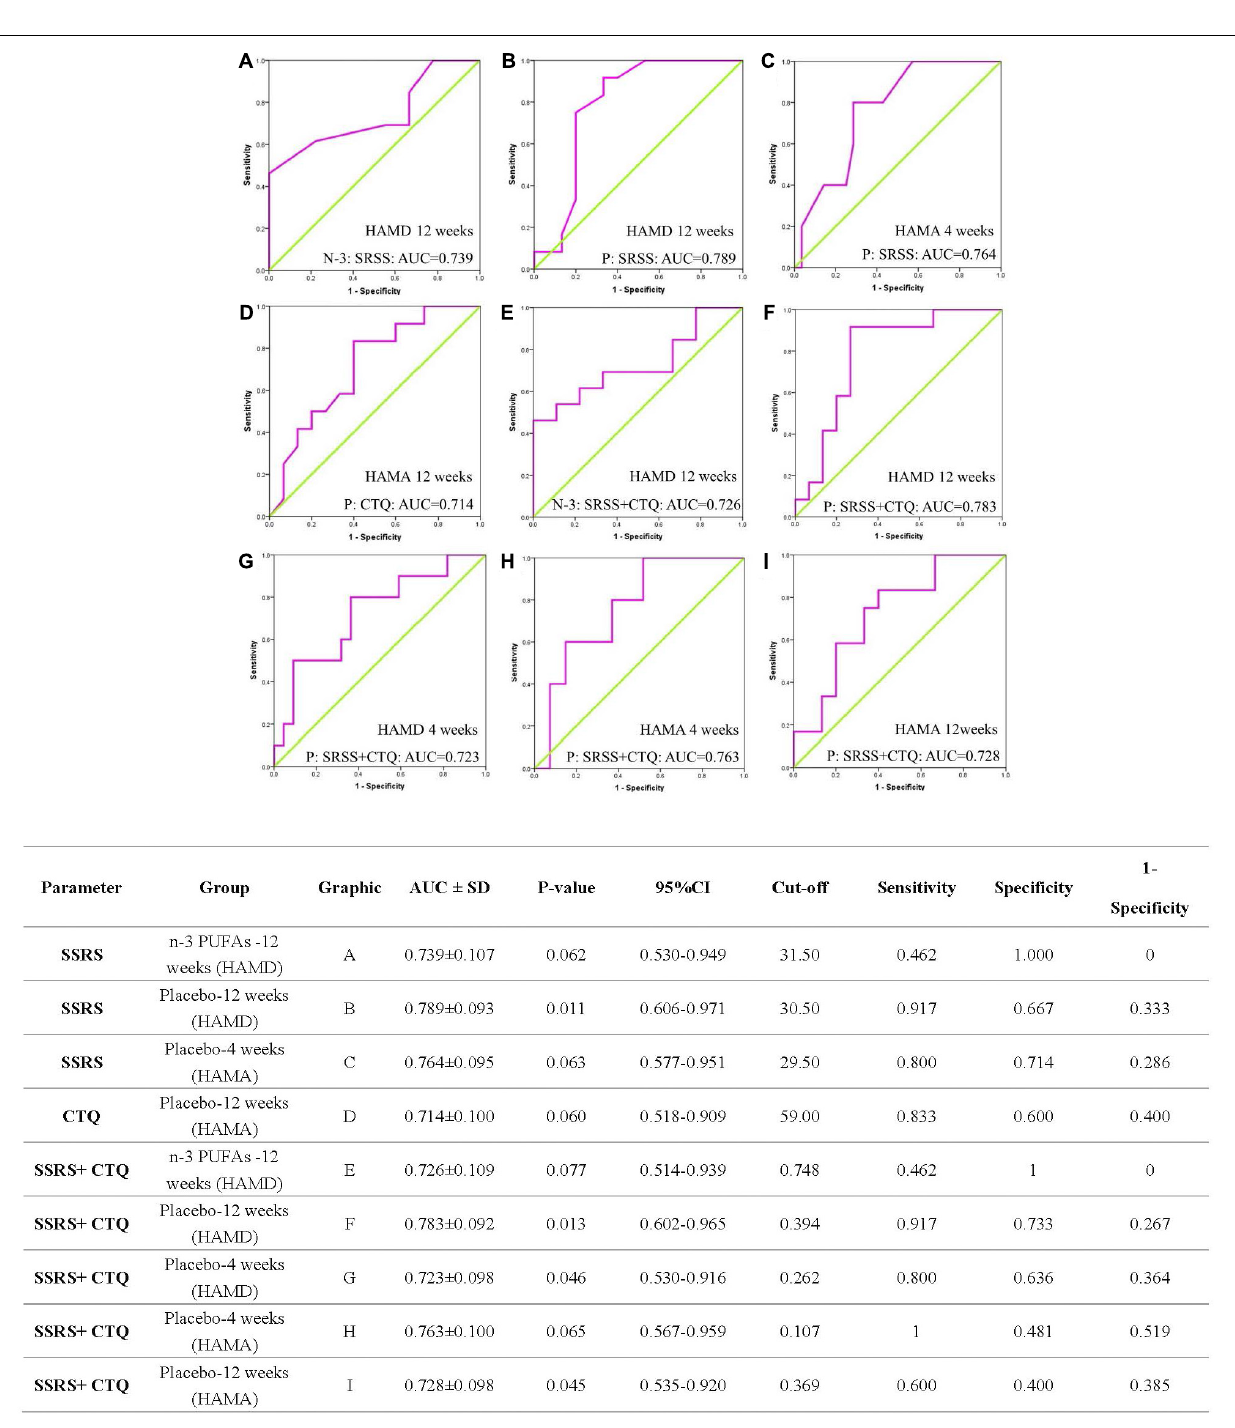
FIGURE 3 | The ROC curve analysis of CTQ, SSRS, and combined effect for the prognosis of patients. ROC, receiver operating curve; AUC, area under the curve; SD, Standard deviation; CI, confidence interval; SSRS, Social Support Rate Scale; CTQ, Childhood Trauma Questionnaire; HAMA, Hamilton anxiety scale; HAMD, Hamilton Depression Scale; n-3 PUFAs, Omega-3 polyunsaturated fatty acids. The N-3 and P in images represent n-3 PUFAs and placebo group